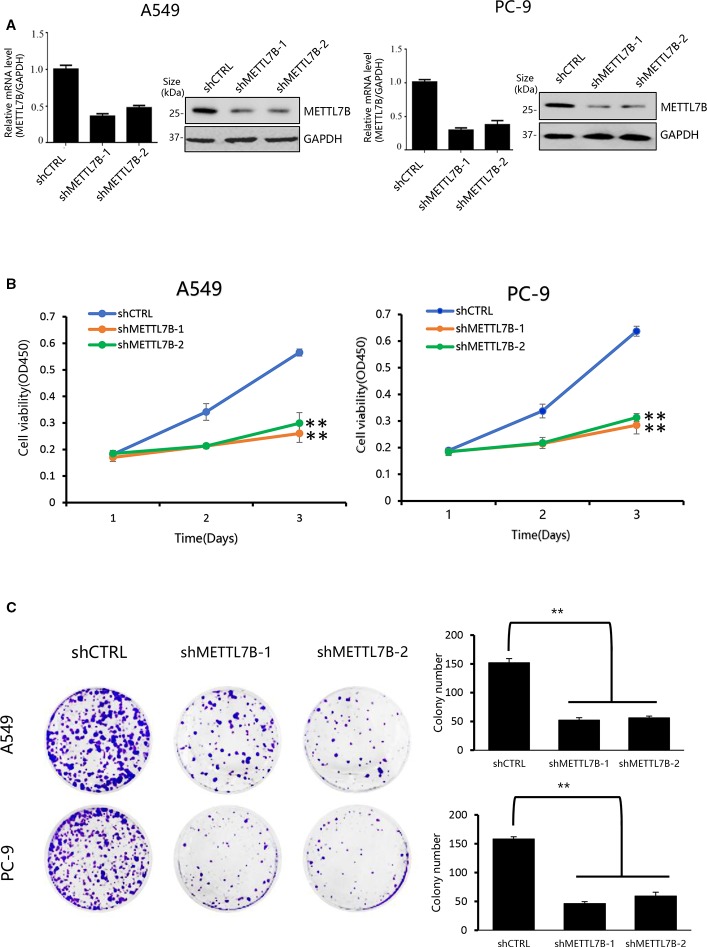
Knockdown of METTL7B inhibits the proliferation of lung cancer cells in vitro. (A) A549 and PC-9 cells transducted with sh-METTL7B (shMETTL7B-1, -2) or shControl RNA (shCTRL) mediated by lentivirus for 48 h. The knockdown efficiency was confirmed by qRT-PCR and Western blot. Error bars = mean ± SD, n = 3. (B) Cell viability assay. After lentivirus infection, cells were collected and seeded in 96-well plates (2,000 cells/well). CCK8 assay applied to measure the cell viability for 3 days. Data are presented as mean ± SD, n = 3. One way ANOVA, **p < 0.01, vs. shCTRL group. (C) Colony-formation assay performed with shMETTL7B or shCTRL cells. After lentivirus infection, cells were collected and seeded in six-well (1,000 cells/well) plate. After incubation for 14 days, colonies were stained by crystal violet and photographed. One way ANOVA, **p < 0.01, vs. shCTRL group. All values are the average of triplicate experiments with the SD indicated by the error bars.